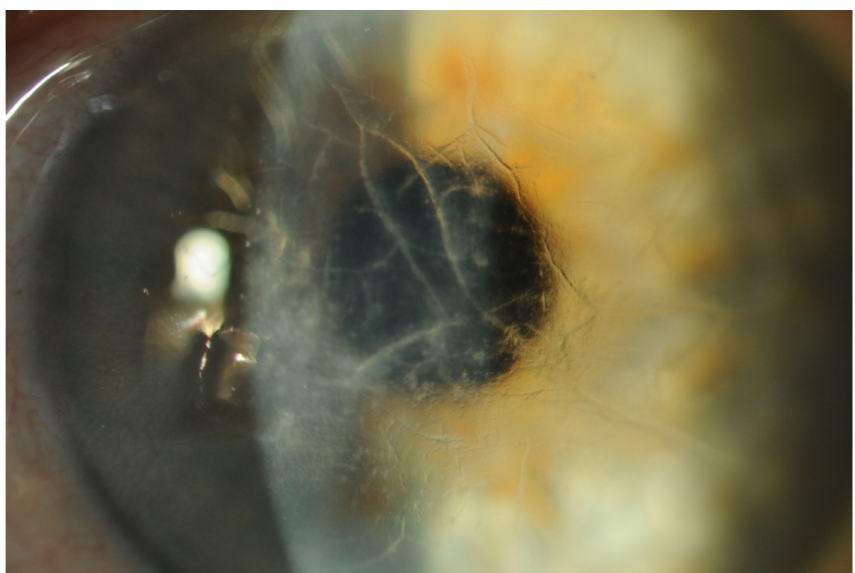
Figure 11. Slit-lamp examination of corneal lattice dystrophy in amyloidotic patients (magnifica- tion 16 ×